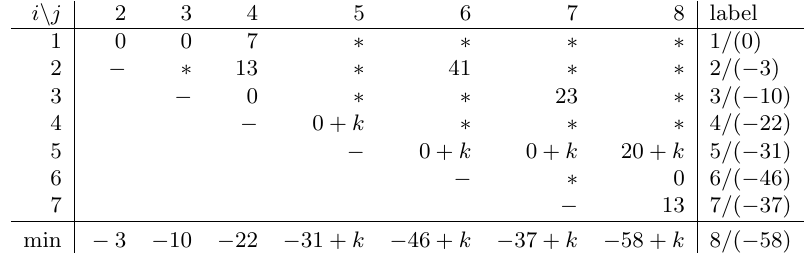
Table 4: Values taken from Table 2, with the duration of activity (4 , 5) reduced by k . Note that no other activity terminates at node 5 (see column 5 in Table 4). The